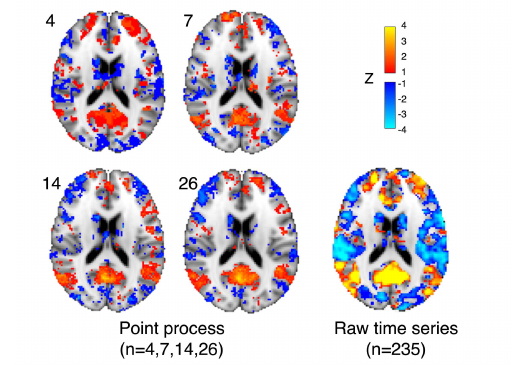
Figure 3: Example of correlation maps obtained from the raw BOLD time series of length n=235 (right panel) and from the derived point process (left panels) for dif- ferent numbers of points (n=4,7,14,26). The left images represent, as “heat maps”, the co-activation of the seed (located at MNI coordinates x=4, y=-60, z=18) with respect to each voxel. Note that a few points already suffice to identify well-defined clusters that are 1-4 stan- dard deviations away from chance co-activations. The right panel corresponds to the Pearson correlation com- puted from the entire length of the raw BOLD time series. Red/blue colors label positive/negative point co-activations in the case of the left maps and posi- tive/negative correlations in the case of the right